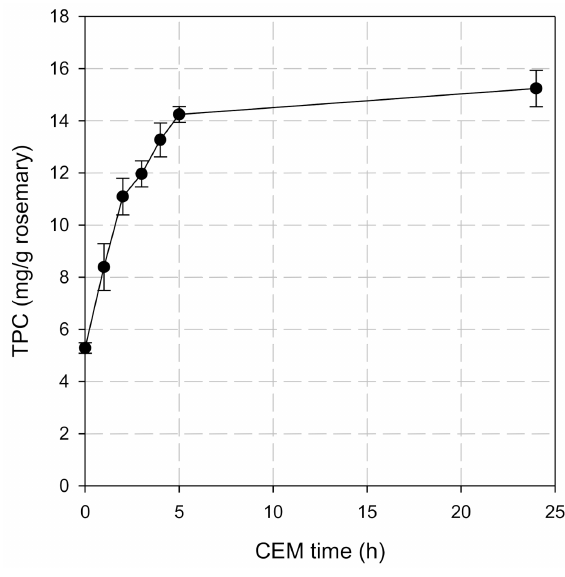
Figure 3. The effect of extraction time on the TPC (mg GAE /g rosemary ) ( •